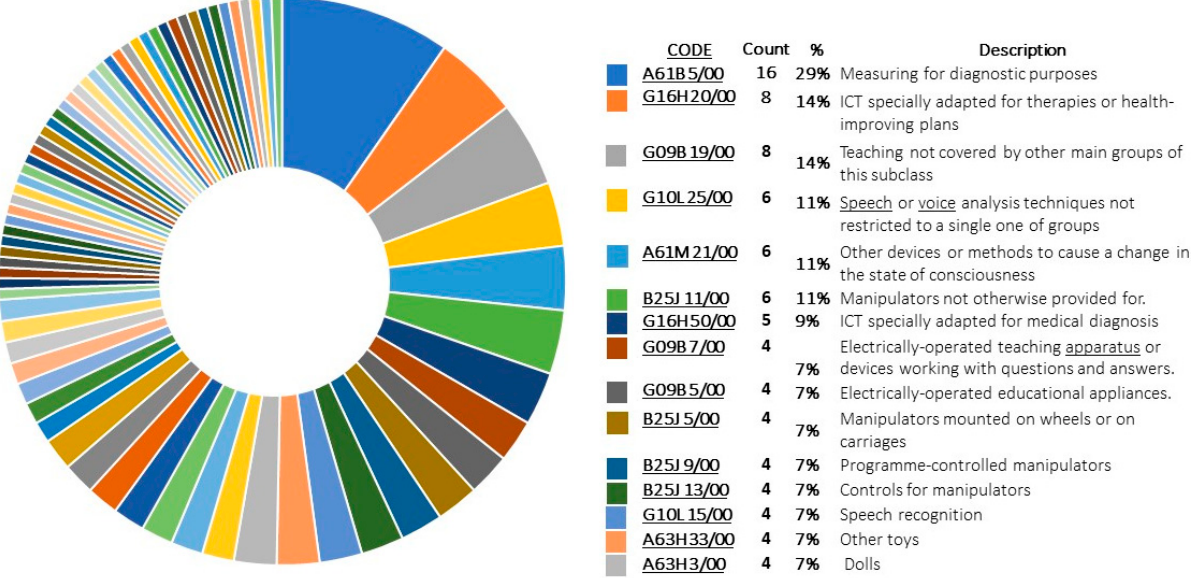
Figure 7. Most common IPC codes in the patent sample.